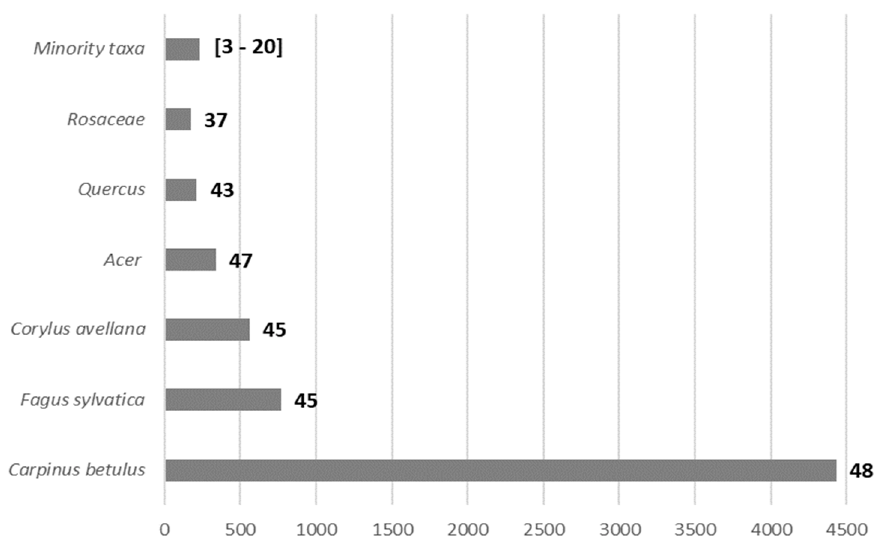
Figure 4. Distribution of abundance among the different taxa recorded for 6720 charcoal pieces identified. Bars represent the absolute frequency (n) and the values next to each bar on the graph express the ubiquity of the taxa in the charcoal kilns (i.e., number of charcoal kilns where the taxon is present among the 48 sampled kilns).